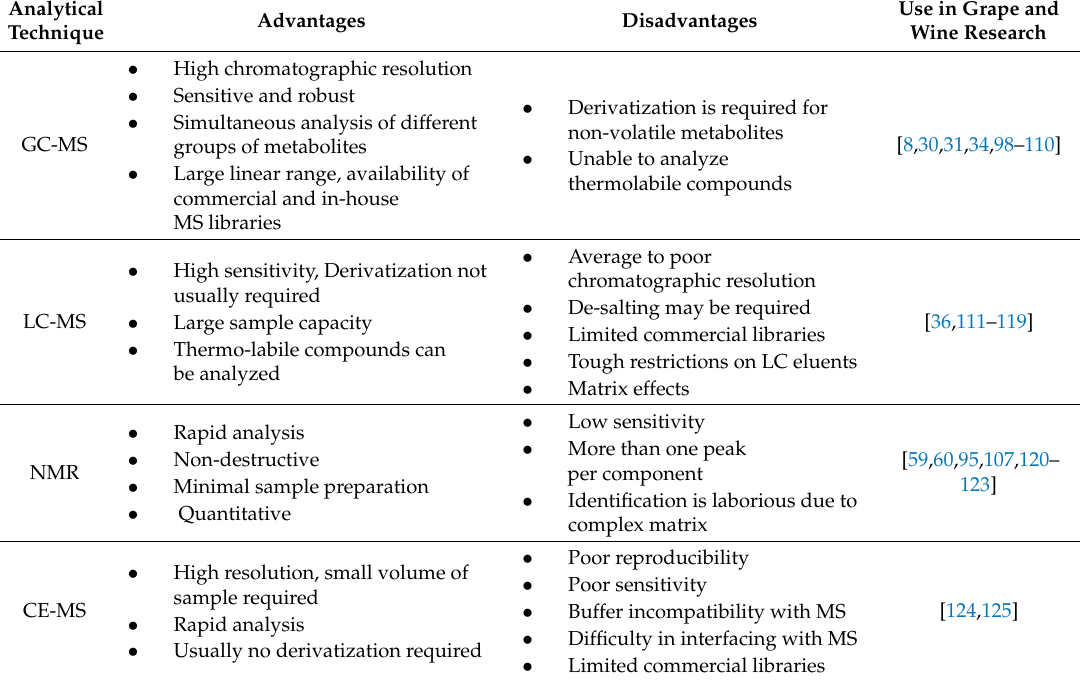
Table 2. Comparisons among different analytical instruments used in targeted and untargeted metabolite analysis of grape juices and